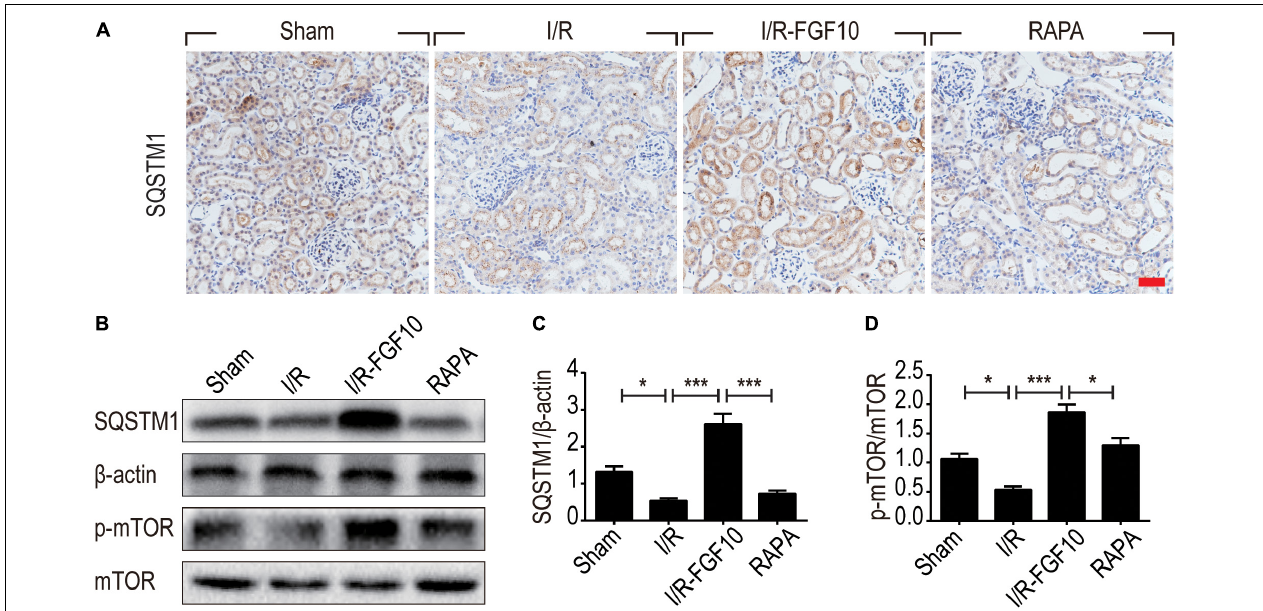
FIGURE 6 | FGF10 increases the expression of SQSTM1 and p-mTOR in I/R rats. (A) IHC staining was performed at 2 days after reperfusion for SQSTM1 in kidney tissues from indicated animal groups. Scale bars = 50 µ m. (B) The expression of SQSTM1, p-mTOR and mTOR were detected by western blotting (mean ± SEM; n = 5). β -actin was used as control. ∗ P < 0.05, ∗∗∗ P < 0.001. (C,D) Optical density analysis for SQSTM1 and p-mTOR, which were normalized to β -actin and mTOR,